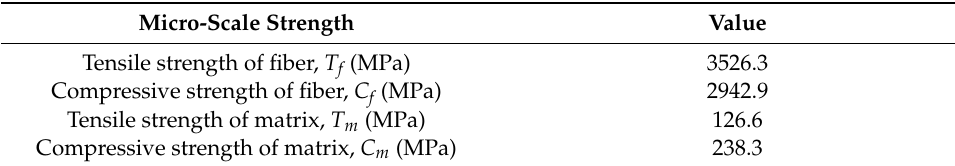
Table 11. Micro-scale strengths of the T300/Epoxy PWF